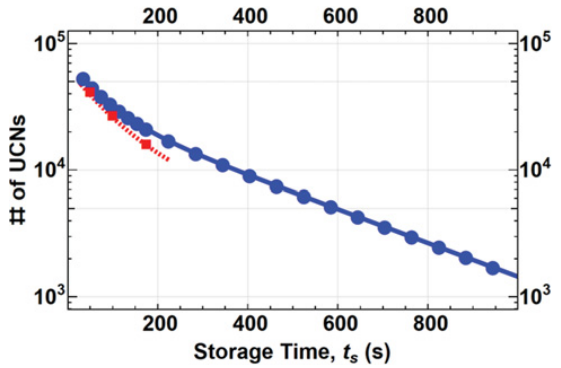
Figure 9. Plot showing the sensitivity to τ B (cid:1) = 0 (90% C.L.) nn (cid:1) achievable as a function of total running time of the experiment. The solid blue line marks the sensitivity projection for the PSI = 380s). nEDM apparatus using 500 s long cycles (with t ∗ s The dashed lines indicate the constraints imposed by older experiments: the flat dashed red curve shows the constraint from Ref. [23], the flat dot-dashed gray line indicates a constraint which is twice that of the constraint in Ref. [23], and the flat solid green line indicates the constraint from Ref.